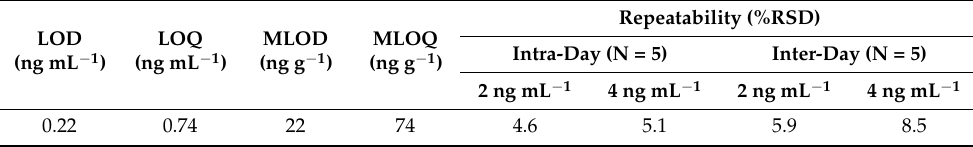
Table 2. Main analytical parameters of the proposed LC-MS/MS